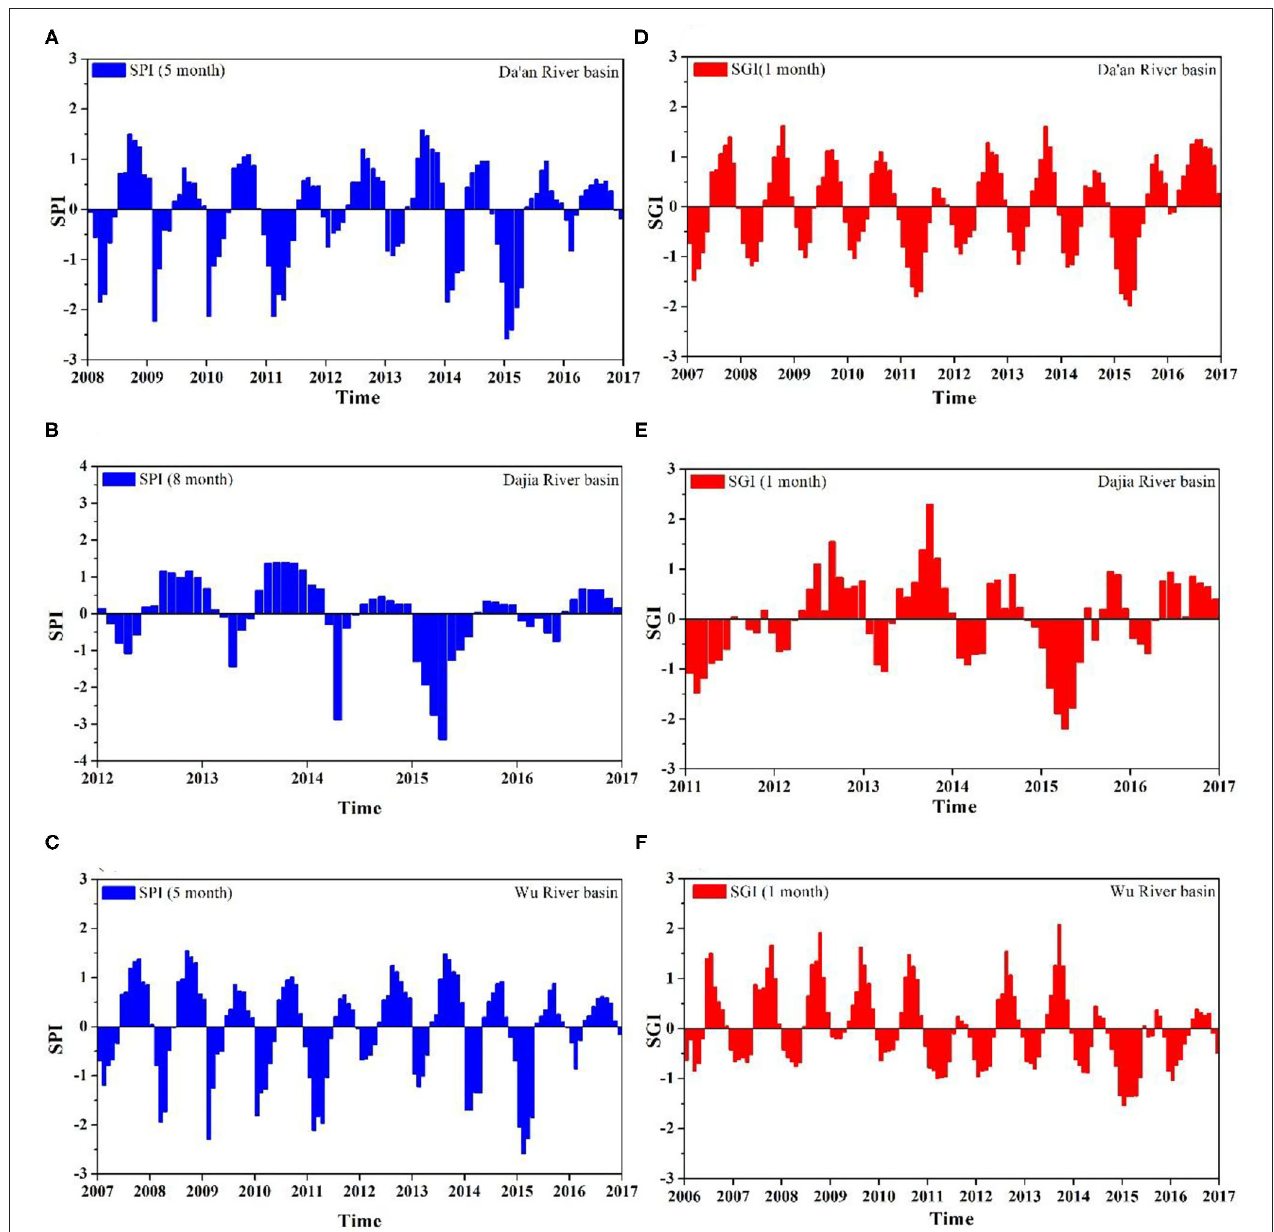
FIGURE 10 | (A–F) SPI q max and SGI time series for various basins.